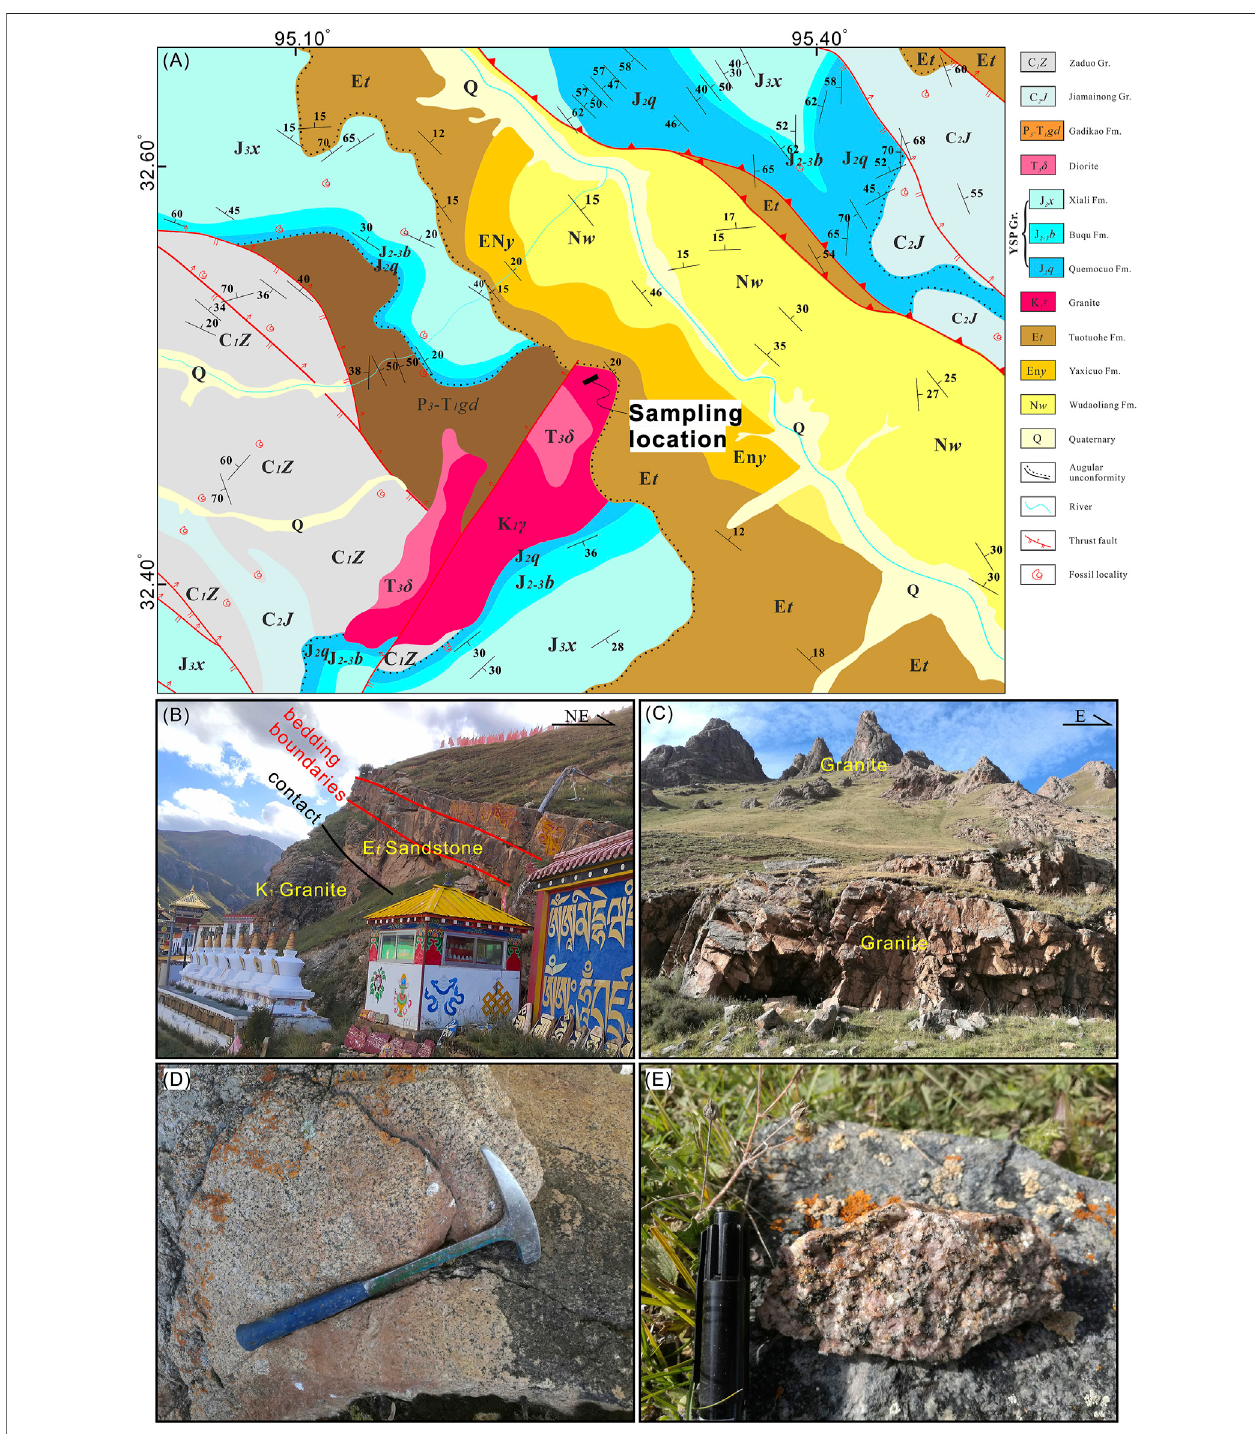
FIGURE 2 | (A) Geological map of the Zaduo area [modi fi ed from the 1:250 000 Zaduo County regional geological map (I46C004004) by the Qinghai Geological Survey Institute (QGSI) 2005]. YSP: Yanshiping; Gr: Group; Fm: Formation. (B) Field photographs showing the contact between the Cretaceous granite and the sandstone of the Paleogene Tuotuohe Formation (E t ). (C – E) Field photographs of representative outcrops and samples, hammer and marker for scale.